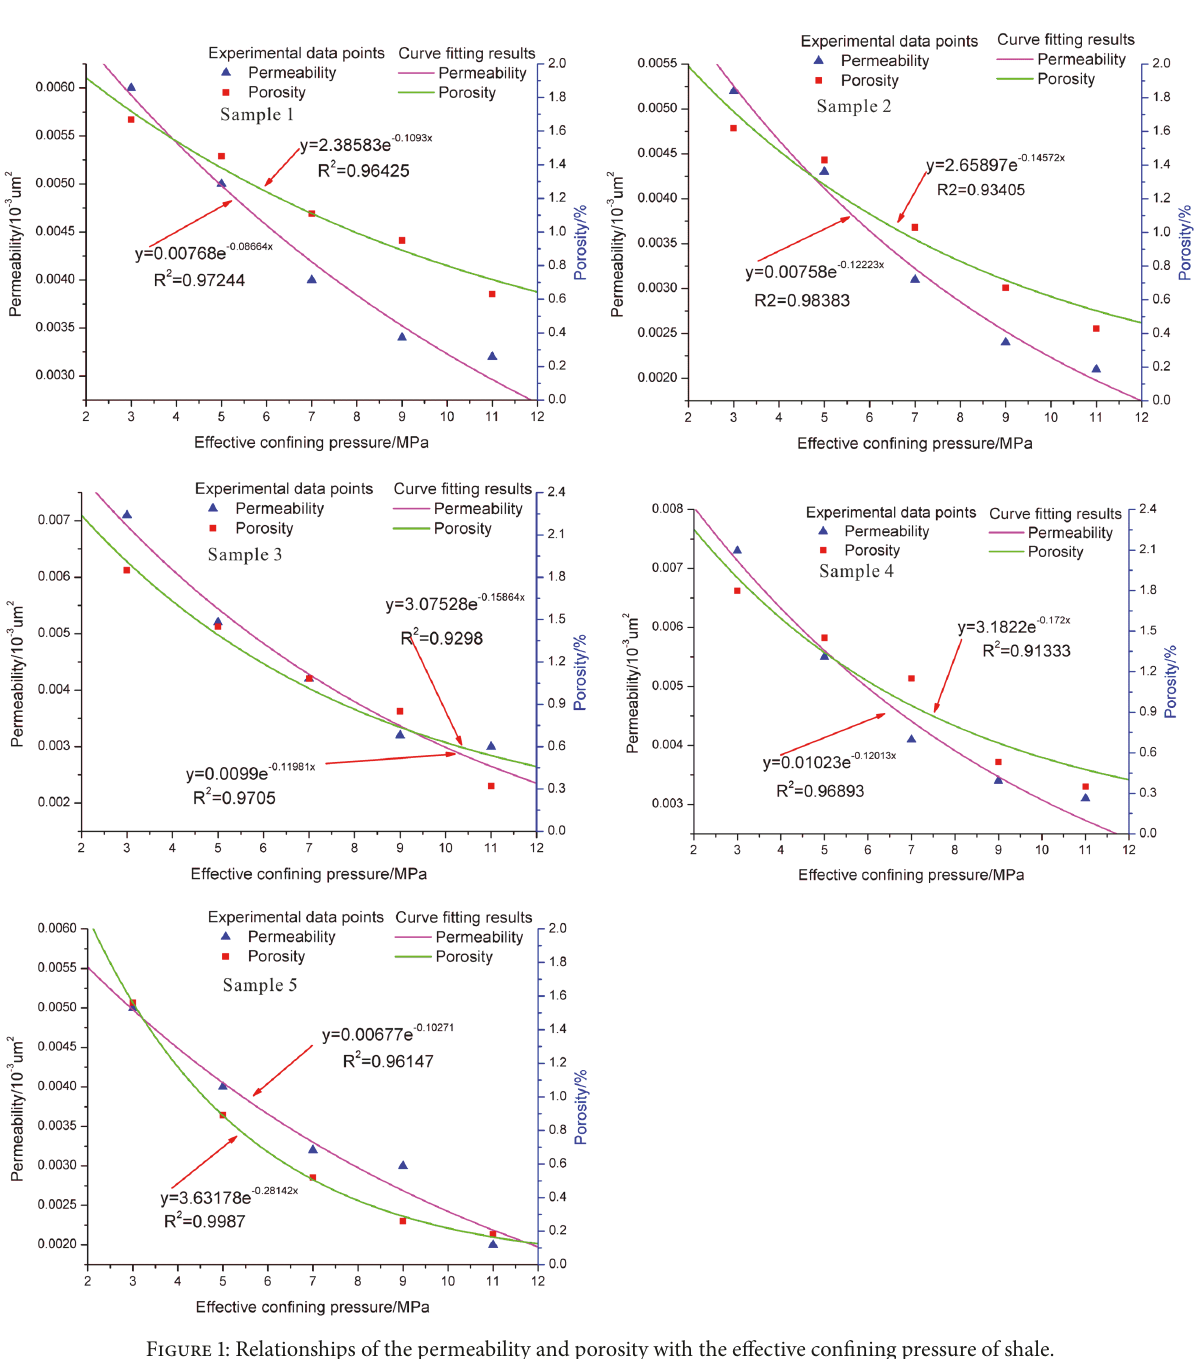
stress (10 −3 𝜇 m 2 ), and n is the stress sensitivity coefficient of permeability (MPa −1